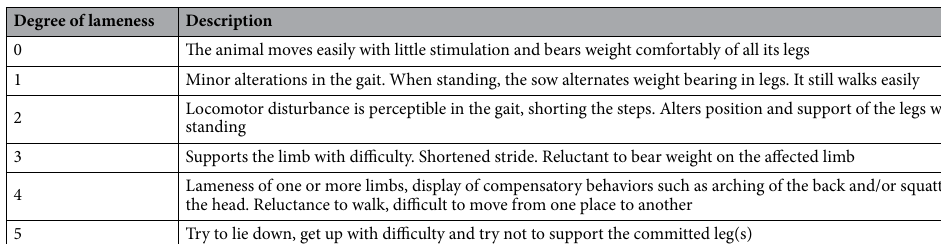
Table 1. Locomotion score system to assess gait in sows . adapted from Refs. 26,27 .